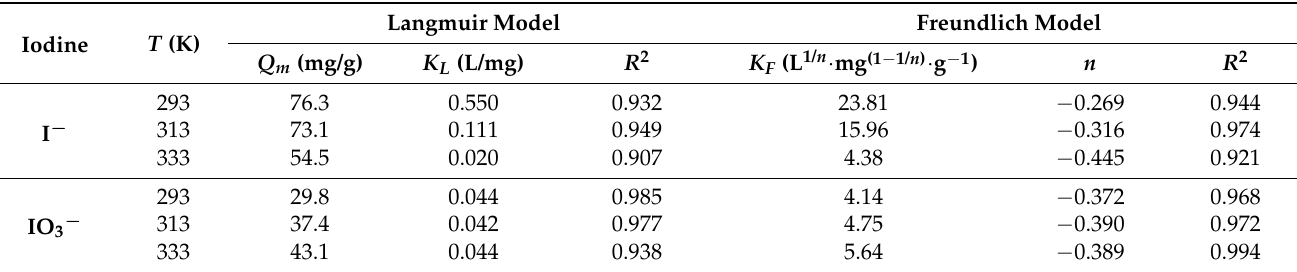
Table 3. Adsorption isotherm parameters of iodide and iodate ions on C-Cu.